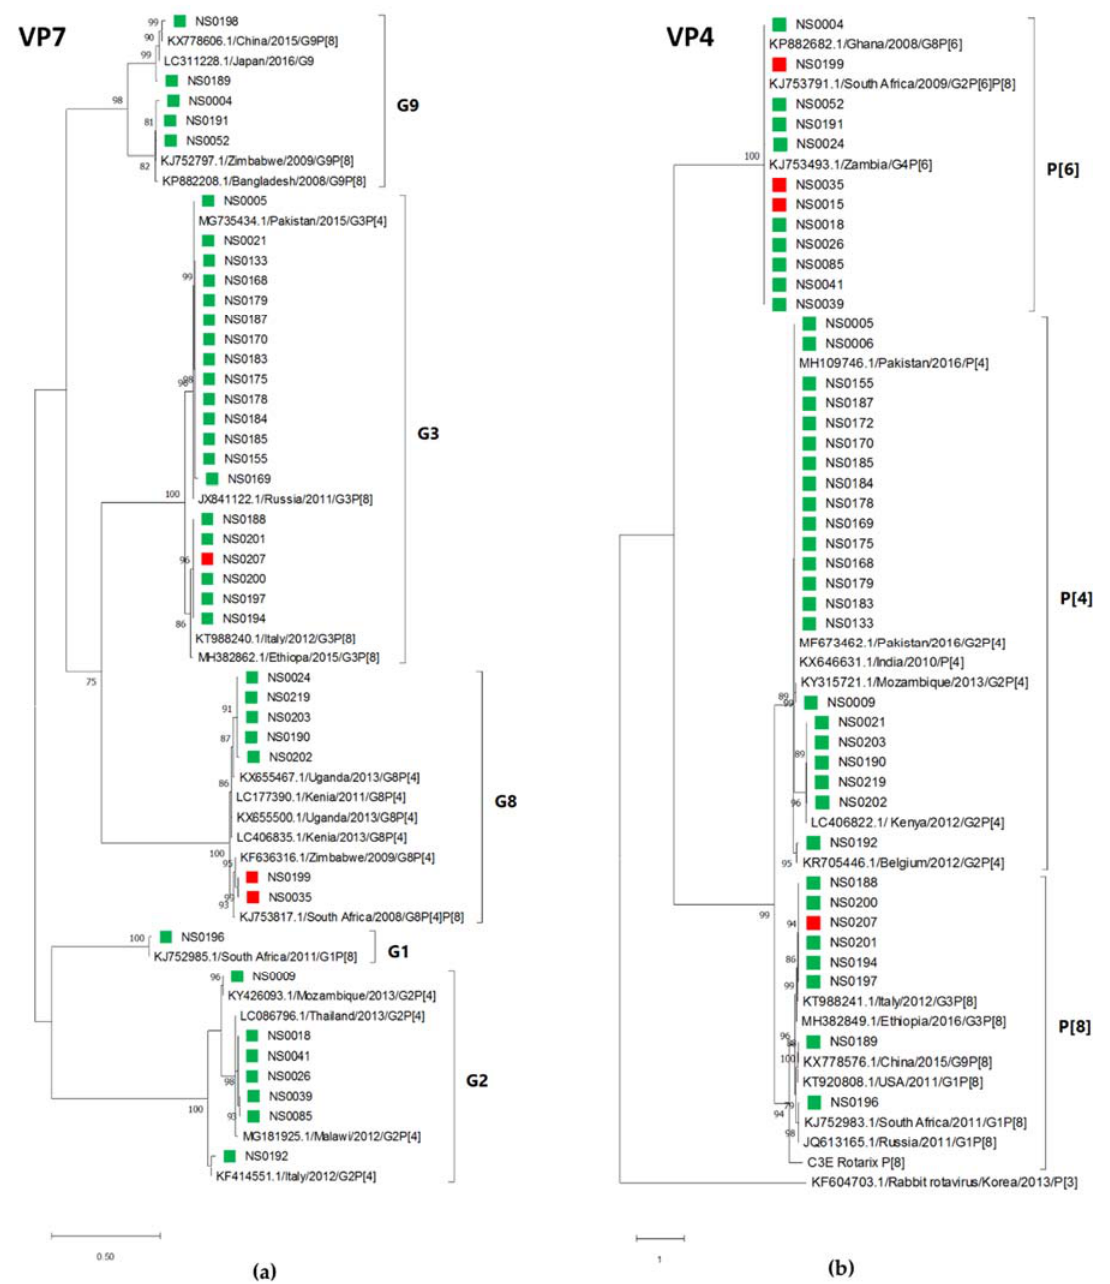
Figure 6. Rotavirus G and P types identified by maximum likelihood phylogenetic analysis of ( a ) the VP7 gene (585 bp) and ( b ) the VP4 gene (555 bp) of the rotavirus strains detected in children hospitalised with gastroenteritis at KPTH between July 2016 and December 2017. Closely related strains from GenBank are indicated by accession numbers. Bootstrap support of >70% is shown. The scale bar represents nucleotide substitutions per site. Secretor status of infected child is indicated by green (secretor) and red (non-secretor) blocks.